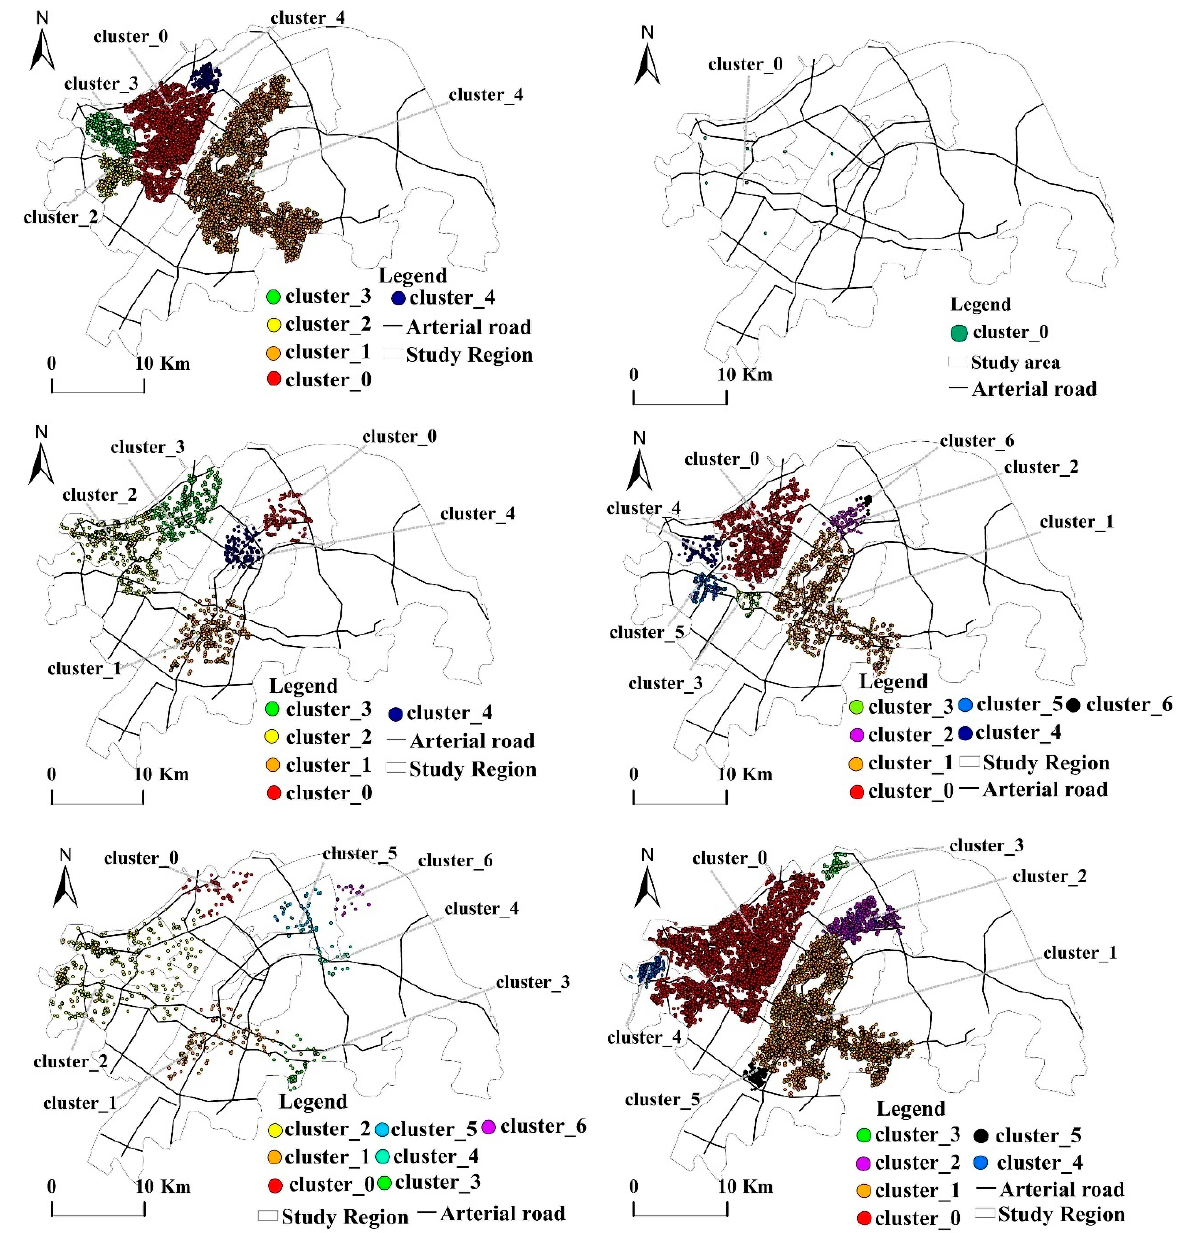
Figure 6. Spatial clustering distribution of production elements.